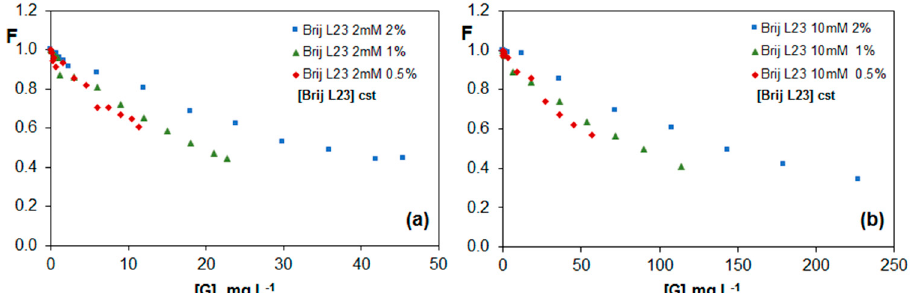
Figure 5. Evolution of fluorescence of vitamin B 2 (F) vs. G concentration for G dispersions in 2 mM ( a ) and 10 mM ( b ) Brij L23 for solutions with a constant surfactant concentration.